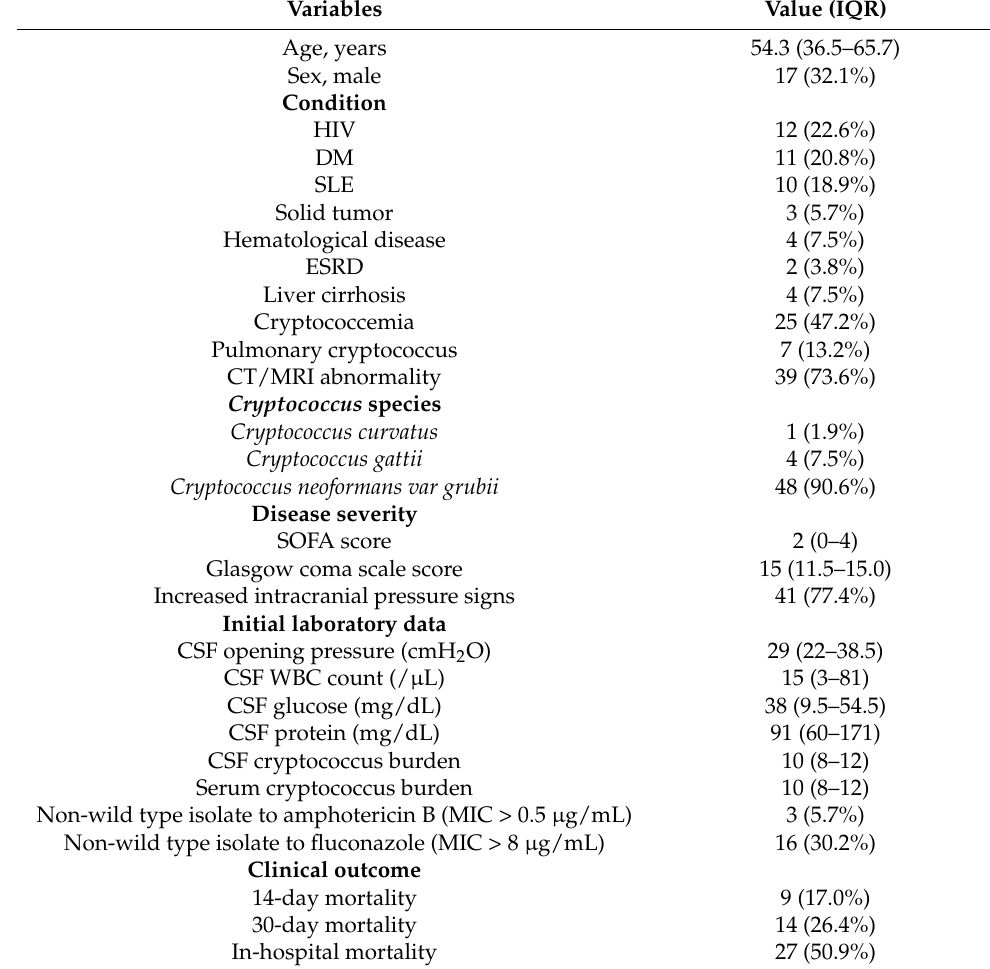
Table 1. Clinical characteristics, demographic data, and outcomes of patients with cryptococcal meningitis.